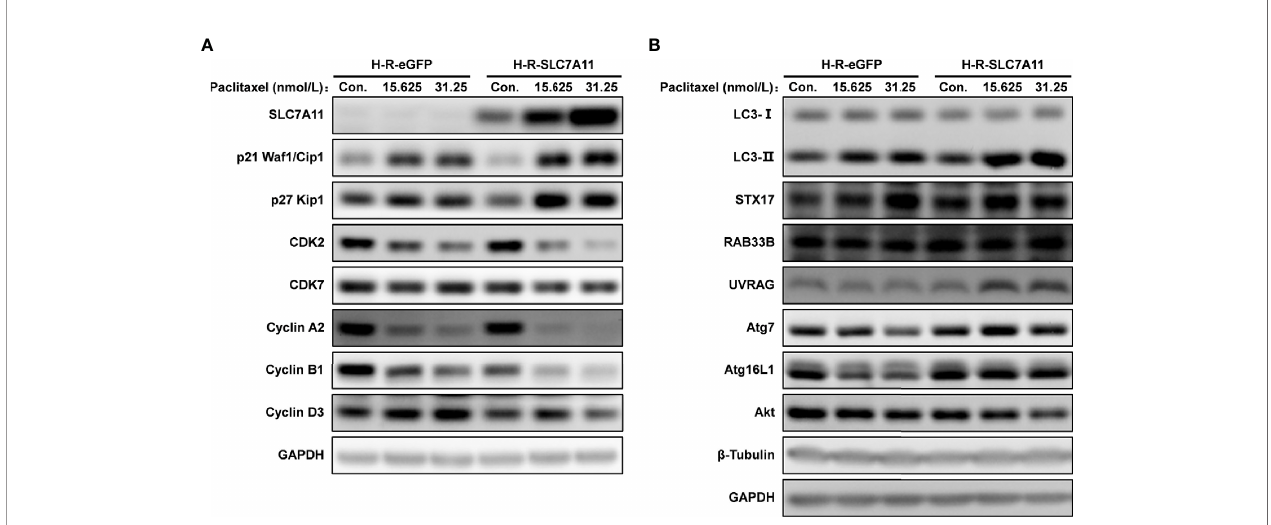
FIGURE 7 | Effects of SLC7A11 and paclitaxel on the expression of related proteins analyzed by western blotting. The H-R-eGFP and H-R-SLC7A11 cells were treated with gradient concentration of paclitaxel for 72 hours. (A) Proteins were extracted and detected by western blotting to analyze the expression of p21 Waf1/